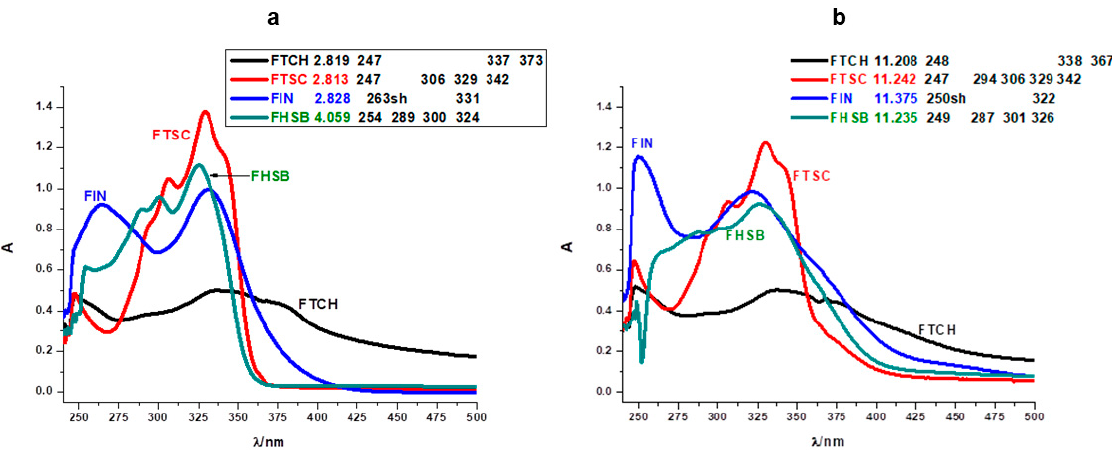
Figure 6. Comparison of absorption spectra of FTCH, FTSC, FIN, and FHSB in acidic ( a ) and alkaline ( b ) ranges. (Origin (Pro) software using the original files from the instrument: Perkin-Elmer Lambda 11 spectrophotometer).